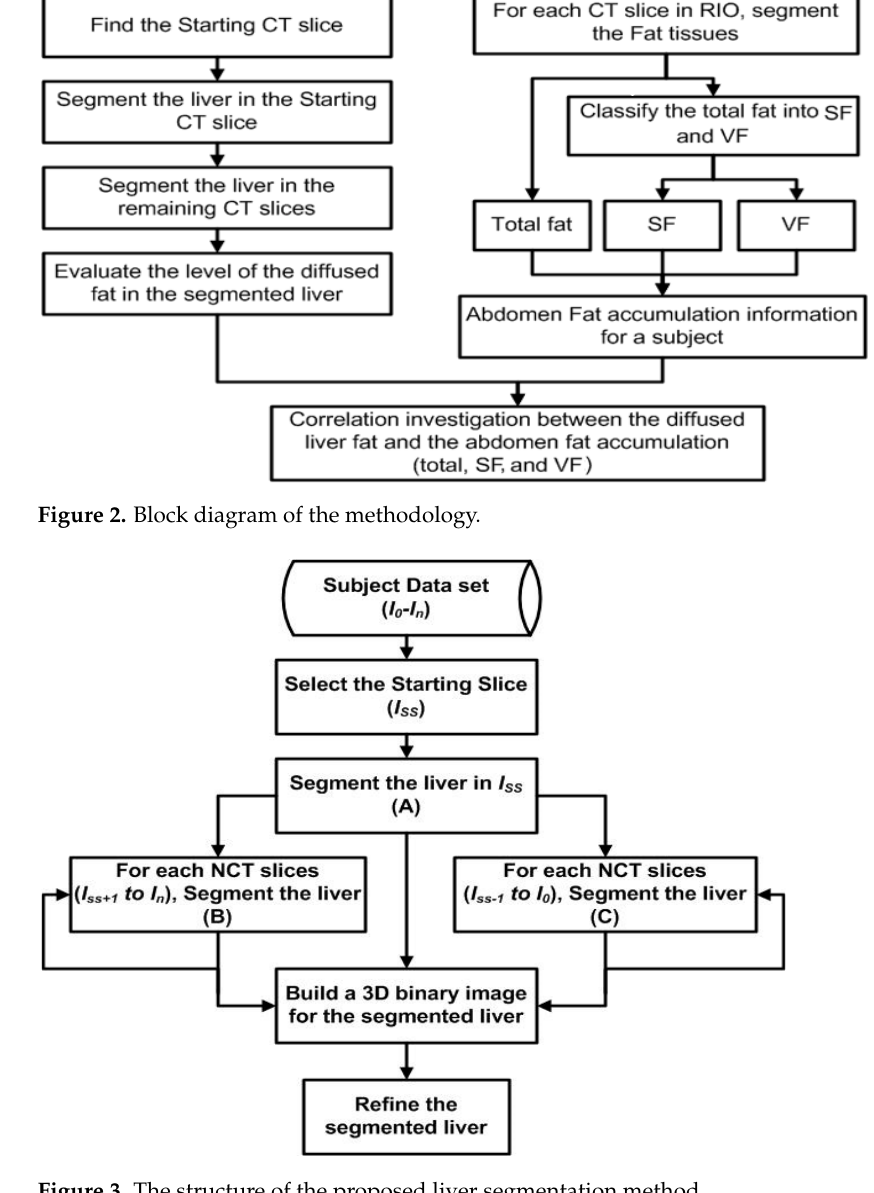
Figure 3. The structure of the proposed liver segmentation method.